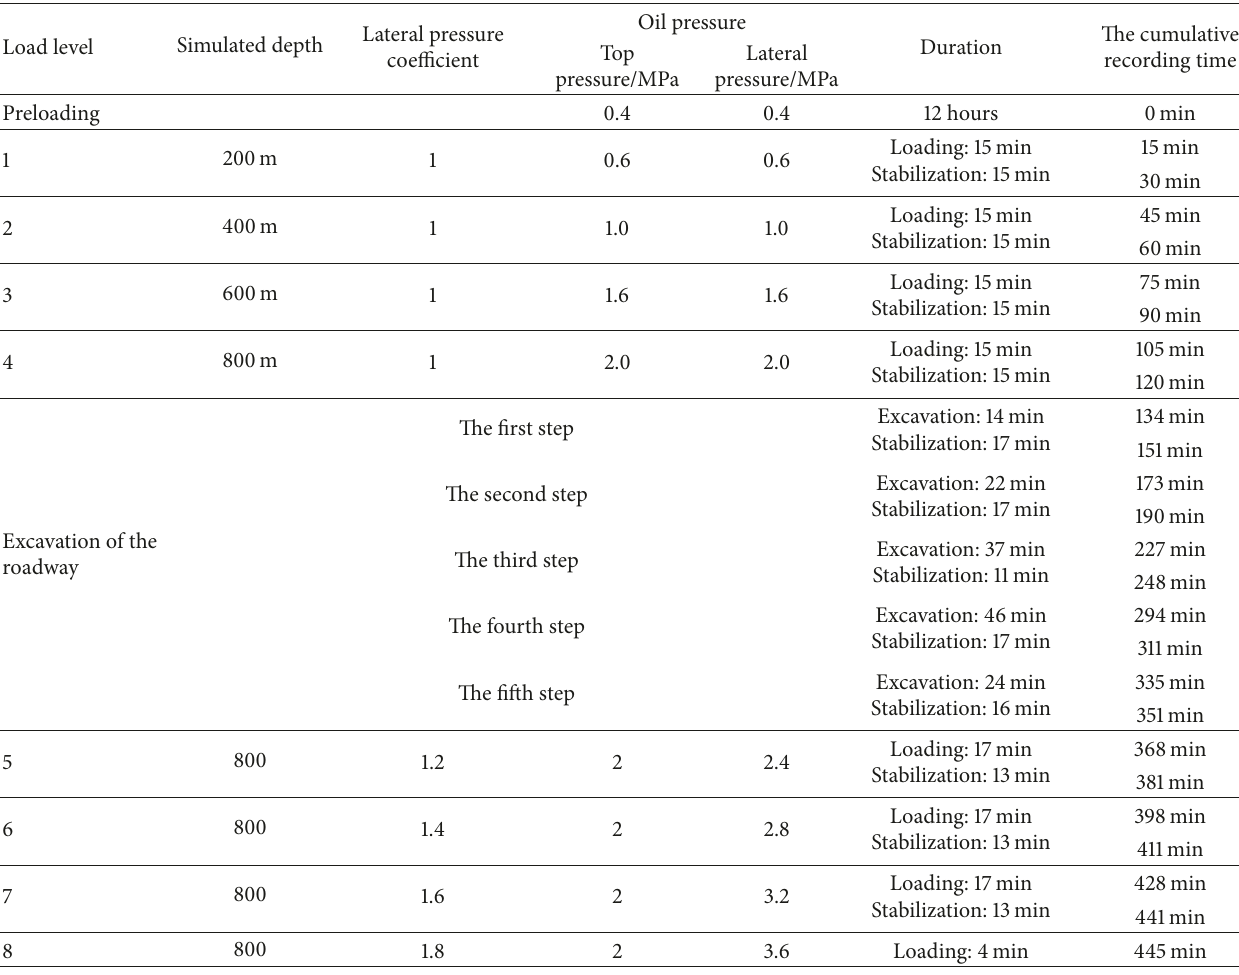
Table 3: The loading plan of the physical model